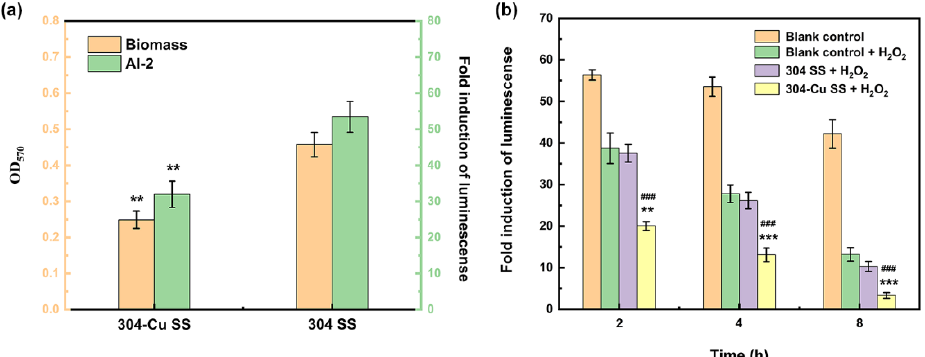
Figure 9. ( a ) Biomass attached to the surfaces of antibacterial 304-Cu and ordinary 304 stainless steels and the corresponding AI-2 signal expression levels. * Indicates significant difference between 304-Cu and 304 (* p < 0.05, ** p < 0.01, *** p < 0.001). ( b ) Changes in AI-2 signal activity under different treatments. All data represent the mean ± standard deviation of three independent experiments. * Indicates significant difference between 304-Cu SS + H 2 O 2 group and blank control + H 2 O 2 group (* p < 0.05, ** p < 0.01, *** p < 0.001); # indicates significant difference between 304-Cu SS + H 2 O 2 group and 304 SS + H 2 O 2 group (# p < 0.05, ## p < 0.01, ### p < 0.001) [79].